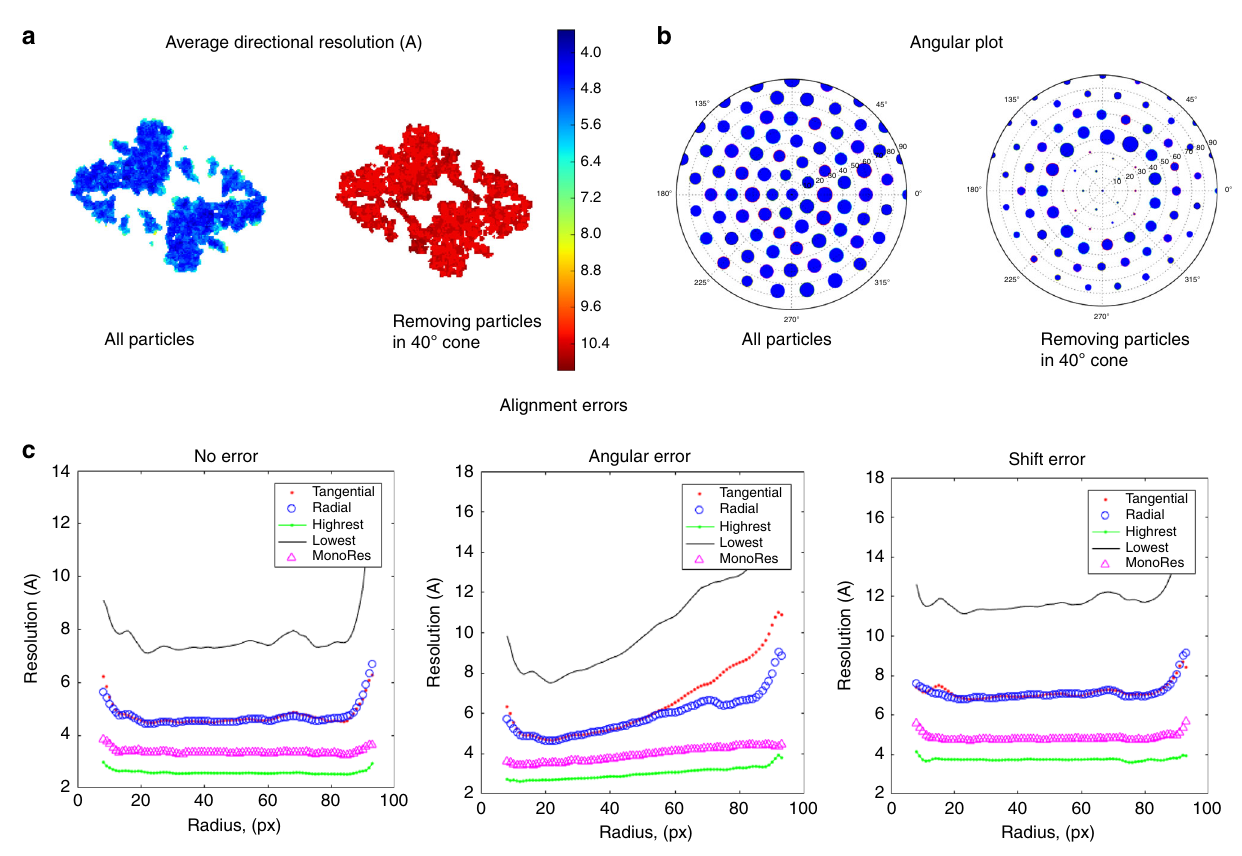
Fig. 1 Results from a computer simulated map from the beta-galatosidase. The atomic model PDB-3j7h was converted into a density map, fi rst for maps obtained considering all projection directions and then with missing directions, showing ( a ) Average Directional Resolution (ADR), ( b ) angular plot, ( c ) radial average of local-directional resolution maps (tangential-pink points, radial-blue circles, as well as lowest and highest) when: random angular errors of standard deviation of 1.2 degrees, random shift errors of standard deviation of 1 degrees, and error free reconstructions are